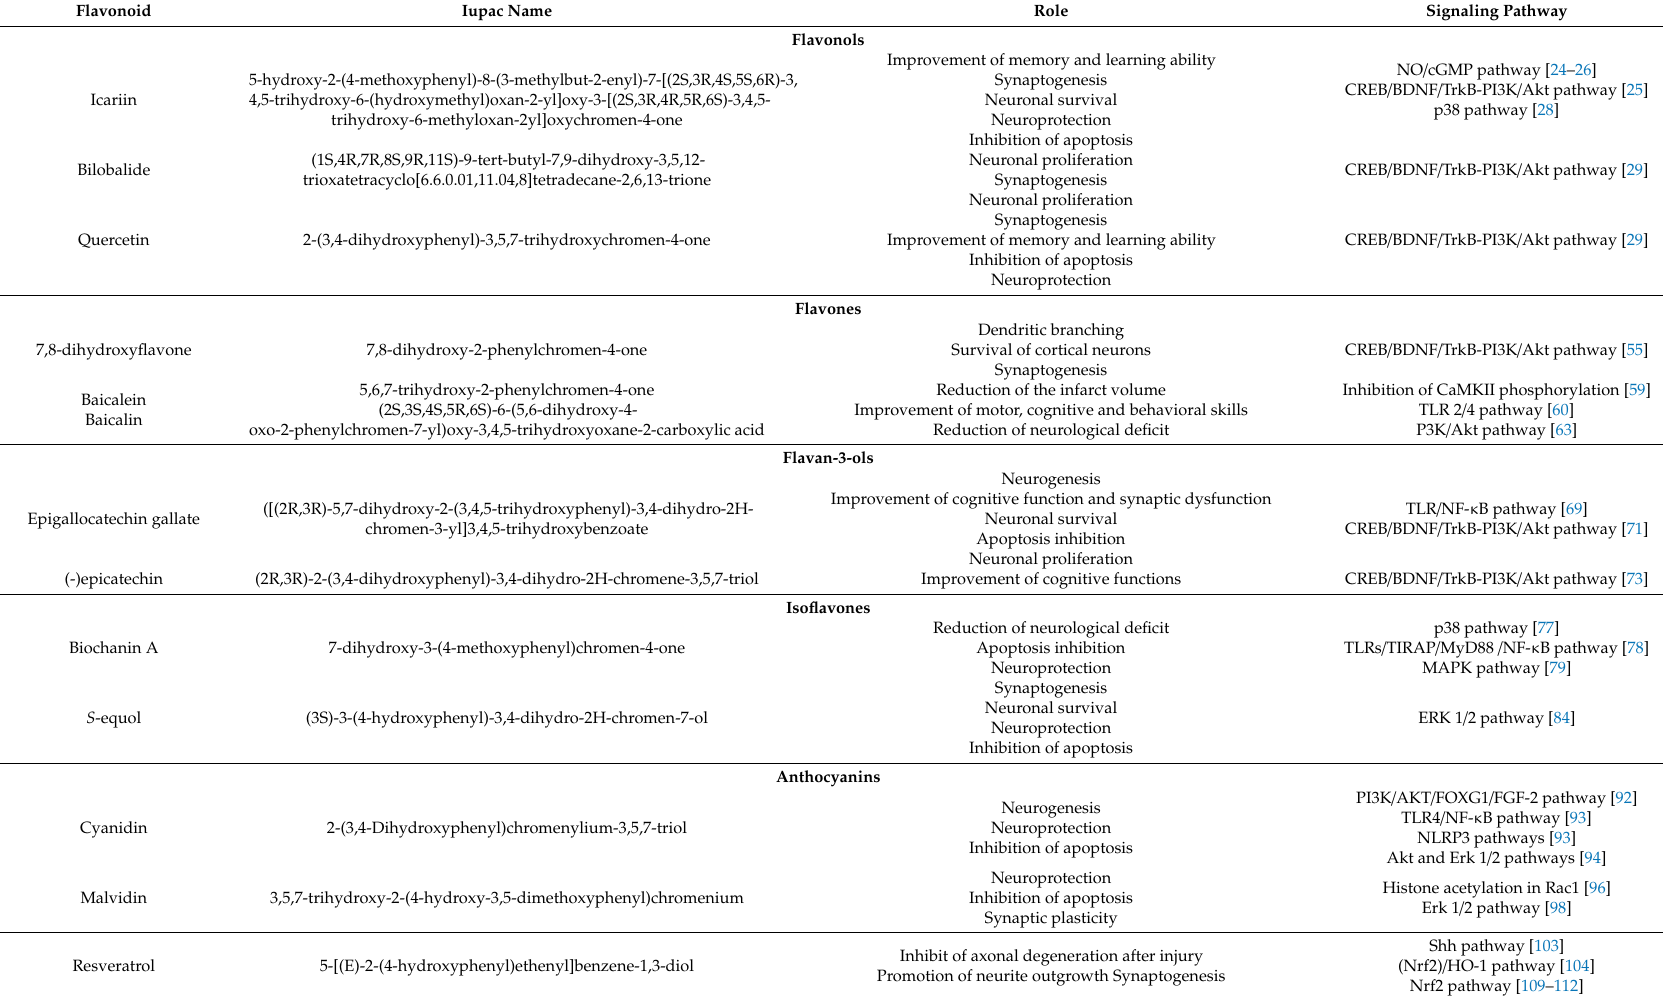
Table 1. Summary of neuroprotective e ff ects of individual representatives of the main flavonoid